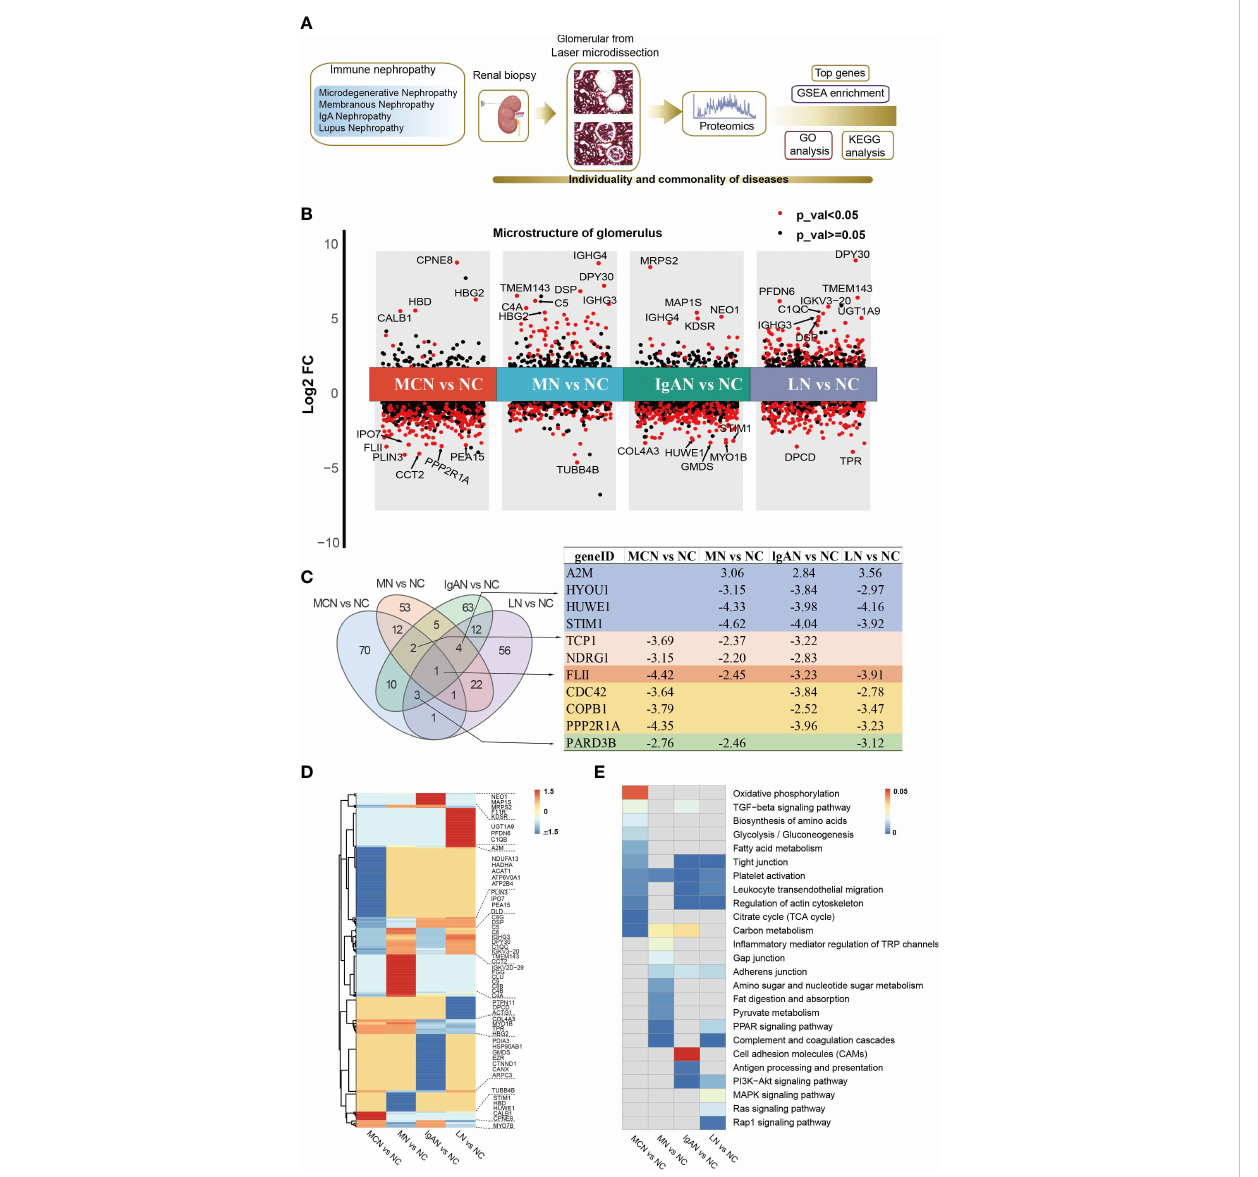
FIGURE 1 Proteomic analysis of glomerular tissue in four GNs diseases. (A) Scheme of the proteomic analysis. (B) Differential protein expression analysis showing up- and down-regulated proteins across all four GNs diseases. P value < 0.05 is indicated in red, while P value ≧ 0.05 is in black. The top 10 of the most signi fi cantly DEPs in each cluster were labeled. (C) Venn graph representing the overlap of the top 100 ranked identi fi ed DEPs in each GNs disease. The characteristic of the shared overlapping proteins that happened in three of four subgroups were presented. (D) The heatmap of the top 100 ranked identi fi ed DEPs in each GNs disease. (E) The heatmap of enriched pathways in the top 100 ranked identi fi ed DEPs of each GNs disease using KEGG analysis. The light grey indicates not available